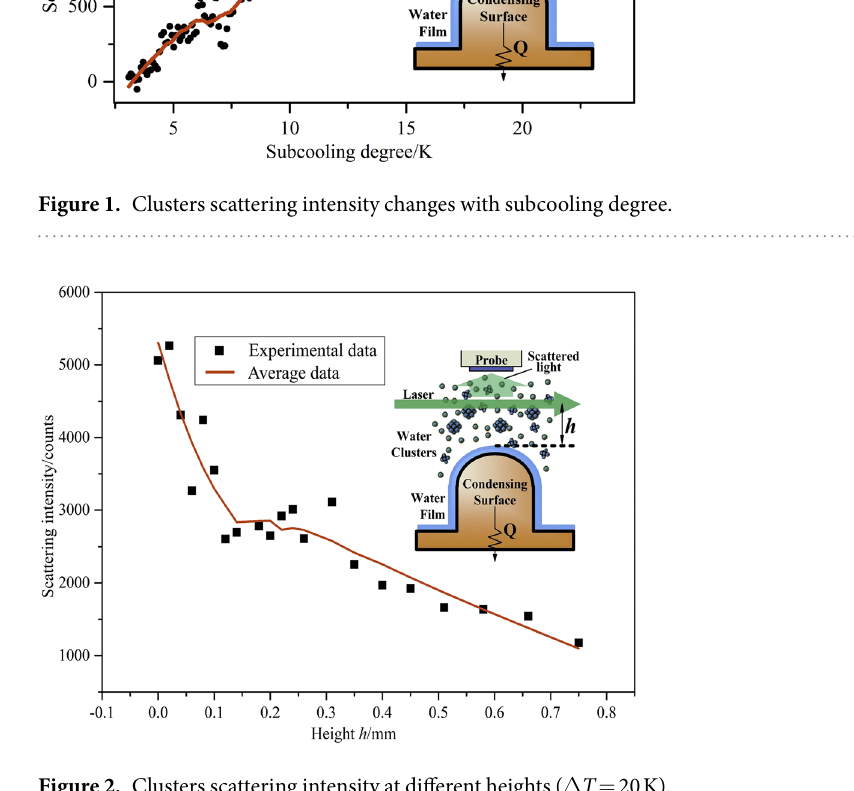
Figure 2. Clusters scattering intensity at different heights ( Δ T = 20